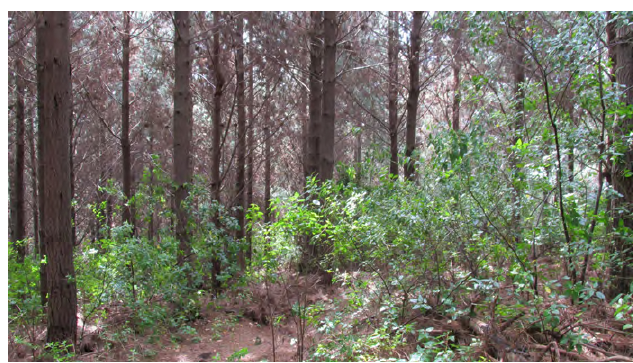
Figure 2. Environment in which Batrachyla taeniata was found, a planta- tion of Pinus radiata with mature understory.